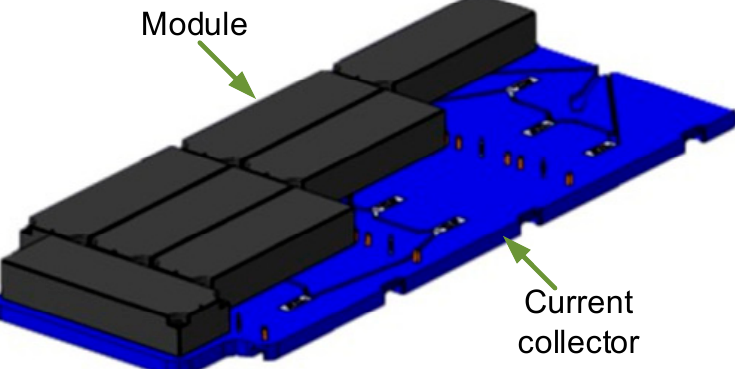
Figure 8. Series connection of the modules.